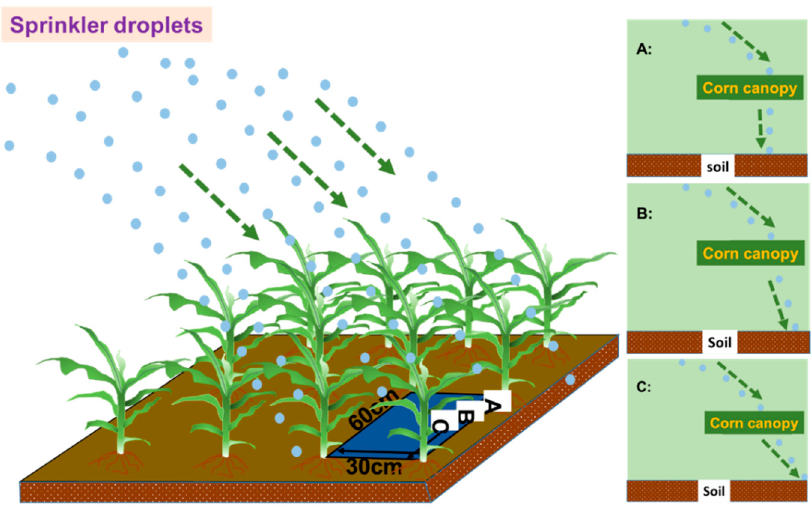
Figure 16. Schematic diagram of effect of maize canopy on sprinkler irrigation droplets landing angles.